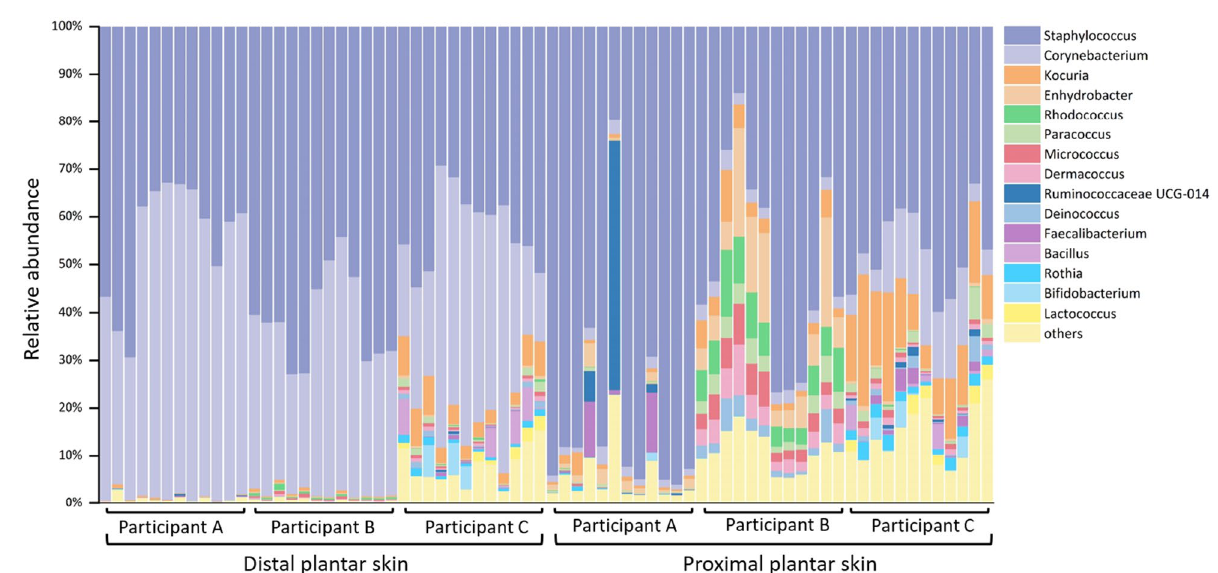
Figure 7. Variation of bacterial community composition between participants for the 15 most dominant genera observed across the distal and proximal plantar Microbial diversity of the distal and proximal plantar skins after 5-h use of the three types of footwear. Among the 72 swabbing samples, a total of 4,993,769 sequences passing quality control were clus- tered into 1238 distinct OTUs, the majority (72.3%) of which were identified at the genus level. No sequences were obtained from the negative controls (unused swabs, socks, and insoles) as insufficient DNA was gener- ated in the amplicon sequencing process. Common skin commensals including Staphylococcus (average rela- tive abundance of 54.46%), Corynebacterium (23.69%), Kocuria (4.00%), and Enhydrobacter spp. (2.16%) were present in all plantar skin samples (Fig. 7) 31–34 . The figure also indicates an increase in the bacterial diversity of the proximal plantar skin compared with the homogenous nature of the distal skin. The differences in diversity could also be observed in the β-diversity results, which revealed significant clustering based on individuals and skin sites. The clustering of individuals was demonstrated to be significant by the unweighted UniFrac distances between samples (Fig. S5A), while the significant clustering of skin sites was clearly demonstrated by both the weighted and unweighted UniFrac distances (Fig. S5B and S5D). However, no significant clustering could be observed between footwear types in either community membership or community structure ( p = 0.723, and p = 0.495, respectively, from Table S4). To eliminate the effects of individuals and skin sites on the diversity analysis of the footwear types, we divided the samples into six subgroups (3 participants × 2 skin sites) and com- pared the weighted/unweighted UniFrac distances between footwear types within each subgroup. Significant differences in weighted UniFrac distance were observed between the footwear types at the distal plantar skin for all participants ( p = 0.006, p = 0.004, and p = 0.003, respectively, for the three participants) (Table S5). One participant had significantly different bacterial communities at the proximal plantar skin in both weighted and unweighted Unifrac distances with different footwear types ( p = 0.015 and p = 0.043 respectively). Here, we need